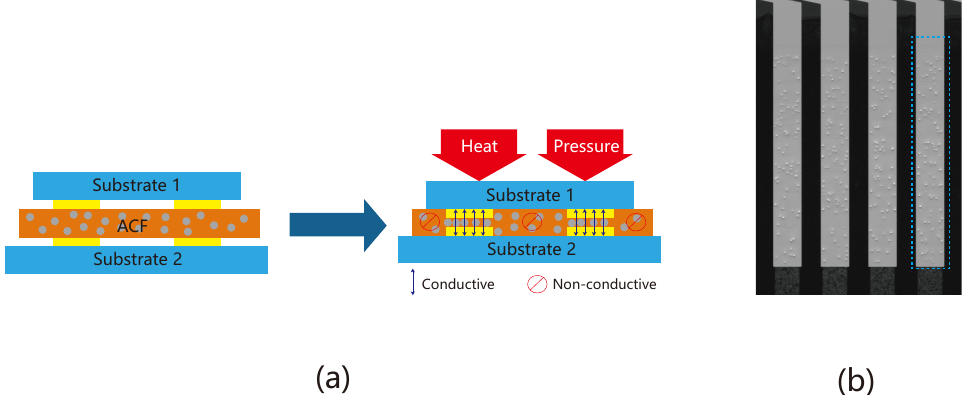
Figure 3. ( a ) Explains the conductivity principle of the ACF; ( b ) shows part of the bump areas after the bonding